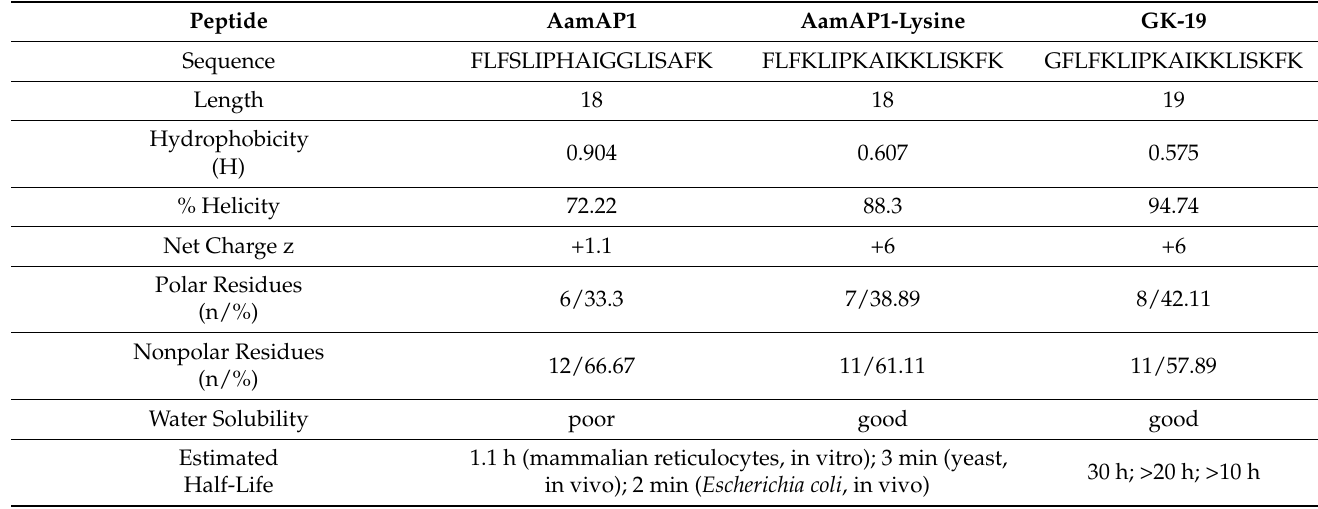
Table 1. Sequence and physicochemical properties of the designed